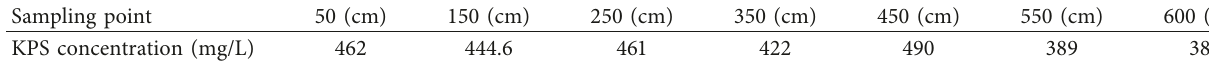
Figure 5: Sample image of emulsification at each point of surfactant-polymer flooding: (a) 0.2 PV; (b) 0.3 PV; (c) 0.5 PV; (d) 0.9 PV; (e) 1.4 PV; (f) 1.7 PV; (g) 1.9 PV. Table 4: KPS concentration at each point at the time of emulsification.